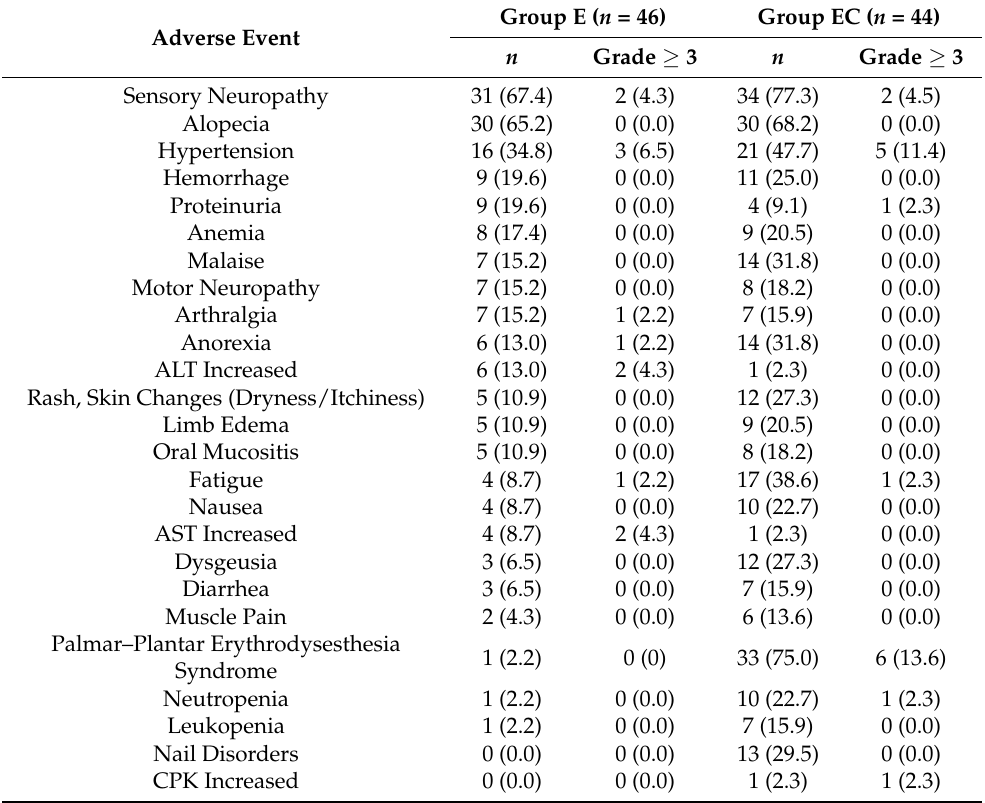
Table 4. Incidence of adverse events (experienced by ≥ 10% of patients or grade ≥ 3 in either group) in patients receiving endocrine therapy alone (group E) or endocrine therapy plus capecitabine (group EC) as maintenance therapy after bevacizumab–paclitaxel induction